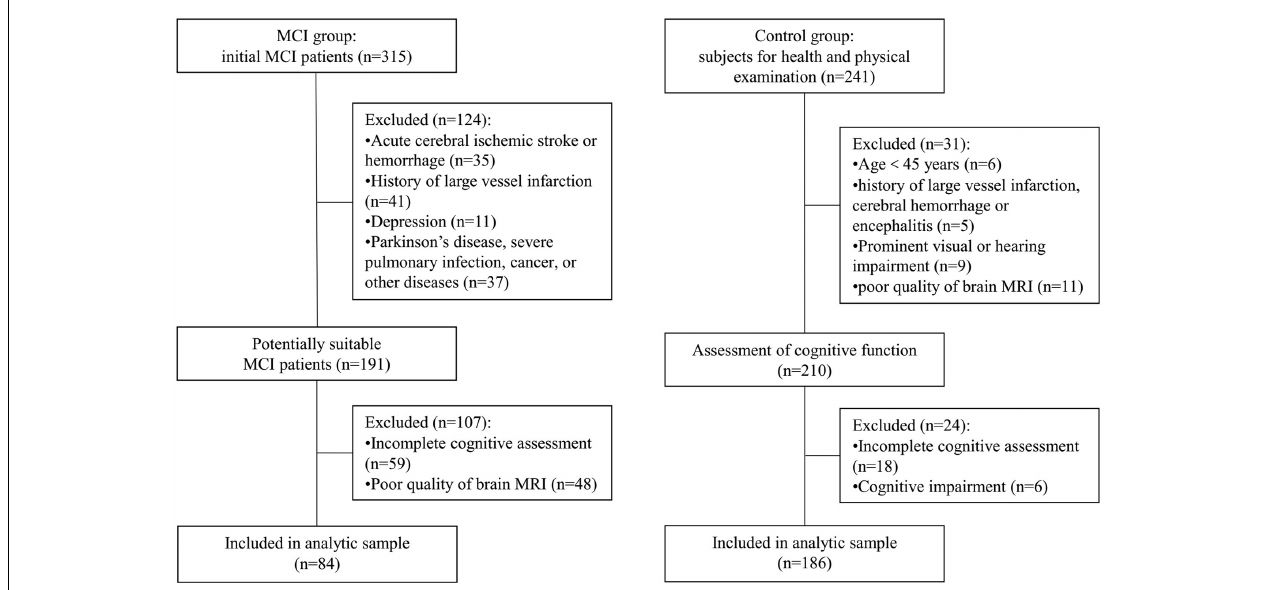
FIGURE 1 | Flowchart of the subjects’ screening. MCI, mild cognitive impairment; MRI, magnetic resonance